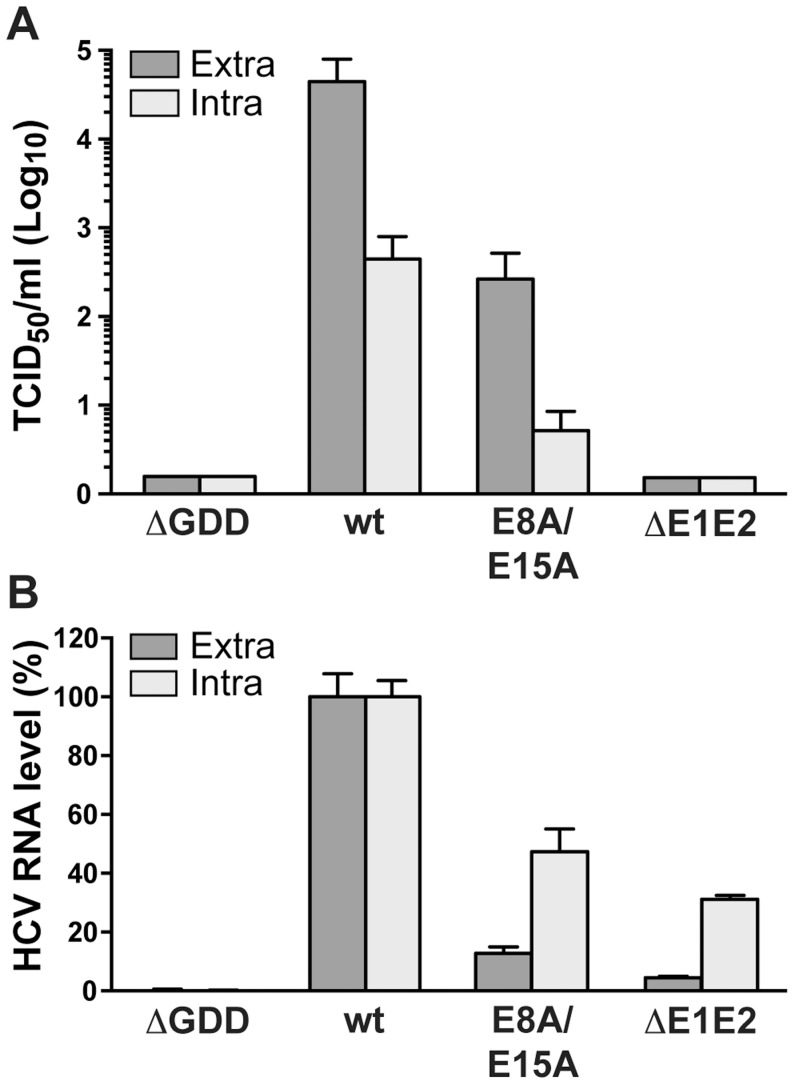
Alanine substitution of the conserved acidic residues on the hydrophilic side of NS4B AH1 affects virus production.(A) Extra- and intracellular infectivity after electroporation of a replication-deficient (ΔGDD), wild-type (wt), E8A/E15A mutant and envelope glycoprotein-deficient (ΔE1E2) full-length Jc1 genomes was determined by 50% tissue culture infective dose (TCID50) measurement at 48 h post-electroporation. (B) Intra- and extracellular HCV RNA levels were determined by RT-PCR 48 h post-electroporation and normalized to GAPDH mRNA level. Results measured for the wt were set to 100%. Note the use of a linear scale as opposed to the logarithmic scale used in panel A.